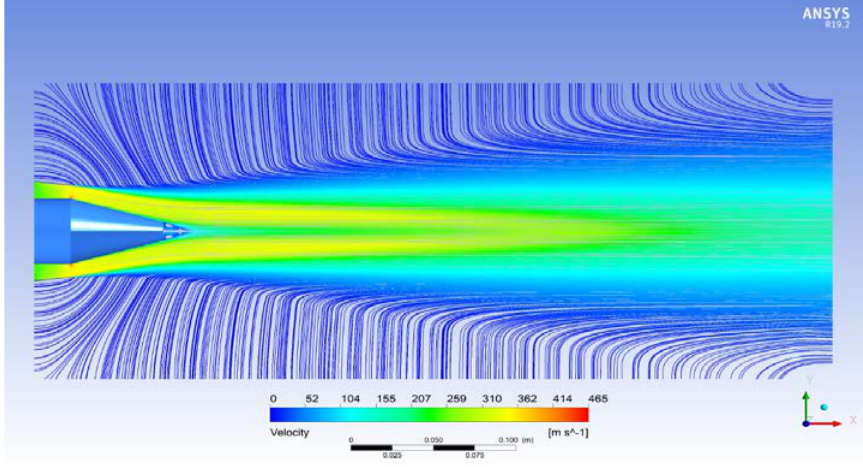
Figure 6. Velocity field and streamlines for the base case without the ejector.